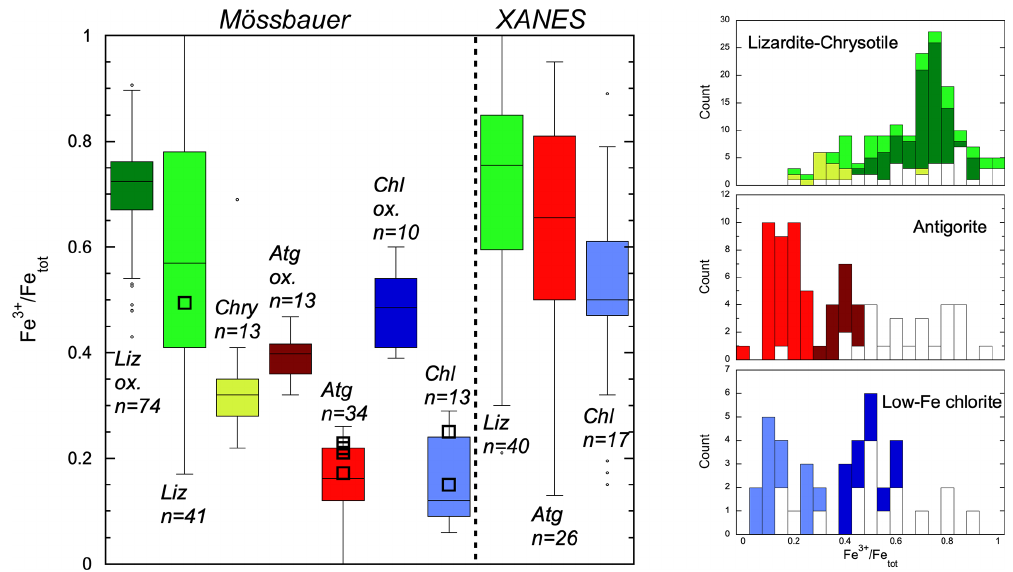
Figure 3. Determinations of Fe 3 + / Fe total ratios in serpentines and Fe-poor chlorites with X Fe < 0 . 2 by Mössbauer and XANES. Liz: lizardites; Atg: antigorites; Chry: chrysotiles; Chl: chlorites. Darker tones are used for populations of samples that were oxidized (ox.) by secondary, likely continental, alteration. The number ( n ) of analyses is indicated for each box. Present data are shown as black squares. Corresponding histograms for lizardite (and chrysotile), antigorite and chlorite are shown on the left (XANES data in white, Mössbauer in